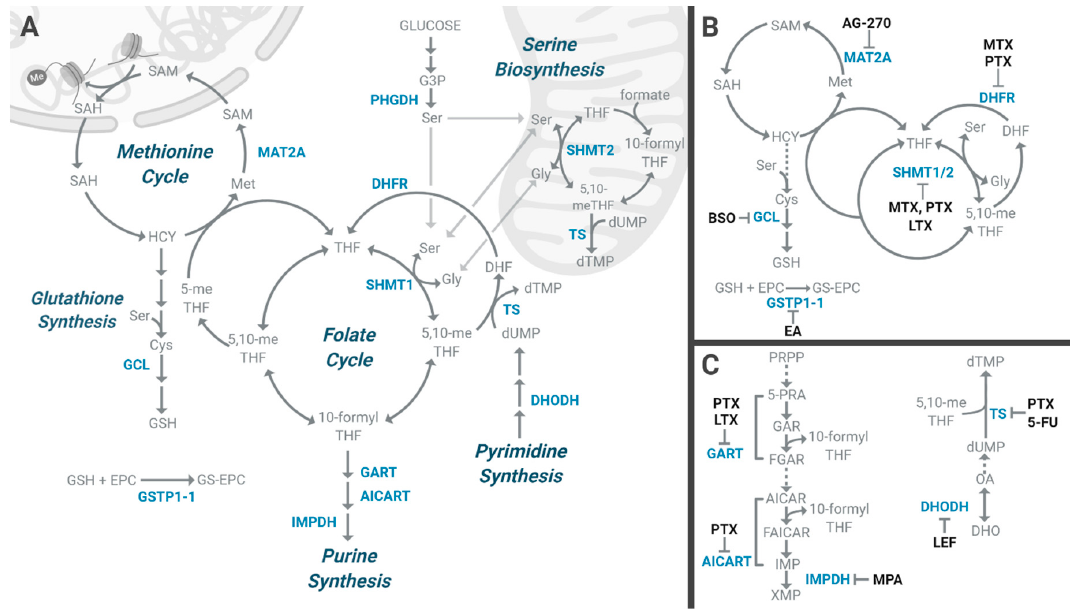
Figure 2. Targetable vulnerabilities related to serine and 1C metabolism. ( A ) Metabolic pathways linked to serine, glycine, and 1C metabolism are shown. Serine biosynthesis requires nitrogen from glutamate and three carbons from the glycolytic intermediate G3P. Serine metabolism is directly linked to the folate cycle, which transfers one carbon unit between metabolites using THF as a carrier. In the mitochondria, serine catabolism produces glycine and 5,10-meTHF in the cytosol 5,10-meTHF is used to synthesize serine from glycine. In both compartments, 5,10-meTHF supports dTMP synthesis from dUMP, a downstream metabolite of pyrimidine synthesis. In the process 5,10-meTHF is converted to the non-carrier DHF, which is converted to THF to re-enter the folate cycle. Purine synthesis is also connected to the folate pathway through a one carbon transfer from 10-formyl. The most reduced carrier is 5-meTHF, which is derived from 5,10-meTHF. The oxidation of 5-meTHF to THF biologically functions to regenerate Met from HCY in the methionine cycle. This ensures a stable pool of SAM for DNA and histone methylation. Through HCY the methionine cycle is connected to the transsulfuration pathway, which generates GSH for ROS mitigation. ( B , C ) Inhibitors targeting enzymes in the folate cycle, the methionine cycle and glutathione synthesis are shown in ( B ) and inhibitors targeting nucleotide metabolism are illustrated in C . Metabolites are in grey, proteins are in blue, and inhibitors are in black. Proteins: AICART: 5-aminoimidazole-4-carboxamide ribonucleotide formyltransferase; DHFR: Dihydrofolate reductase; DHODH: Dihydroorotate dehydrogenase; GART: Phosphoribosylglycinamide formyltransferase; GCL: Glutamate-cysteine